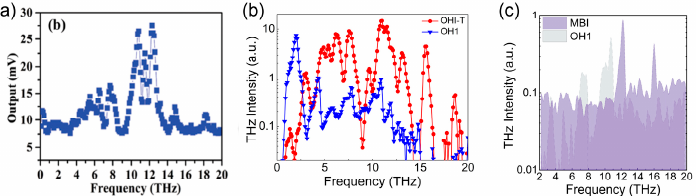
Figure 24. Tuning the THz generation of ( a ) HDB-T [48]; ( b ) OHI-T [53]; and ( c ) 0.8 mm-thick MBI and 0.16 mm-thick OH1 [55].